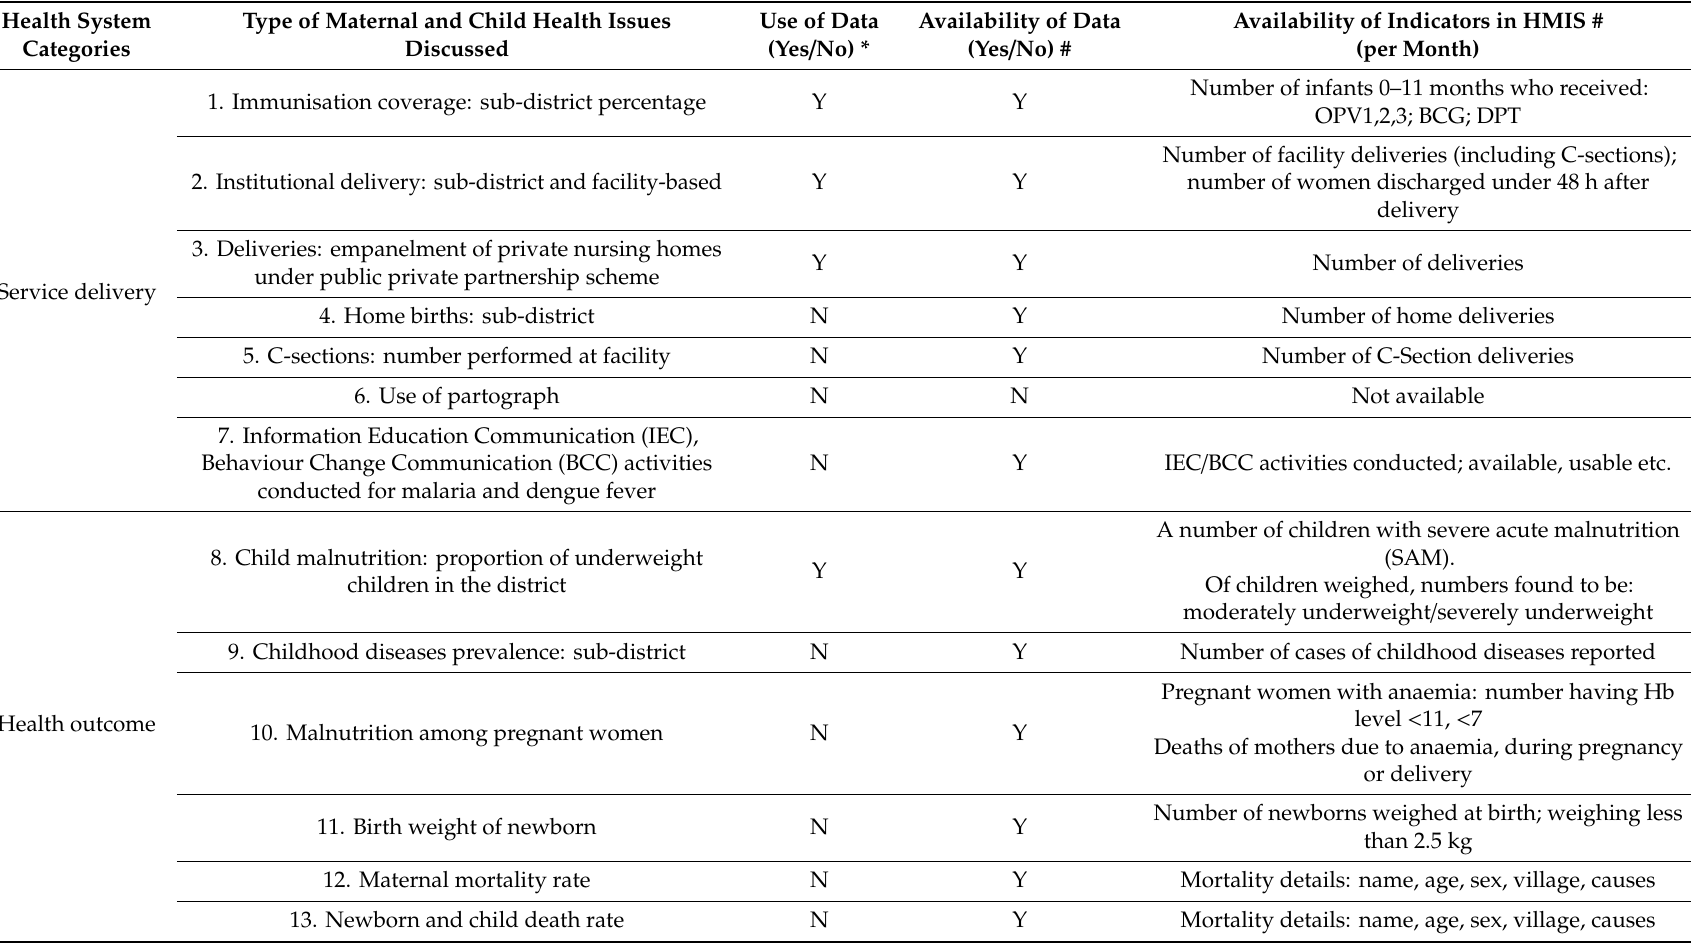
Table 2. Use of data for decision-making related to maternal and child health issues in the District Health Society (DHS)